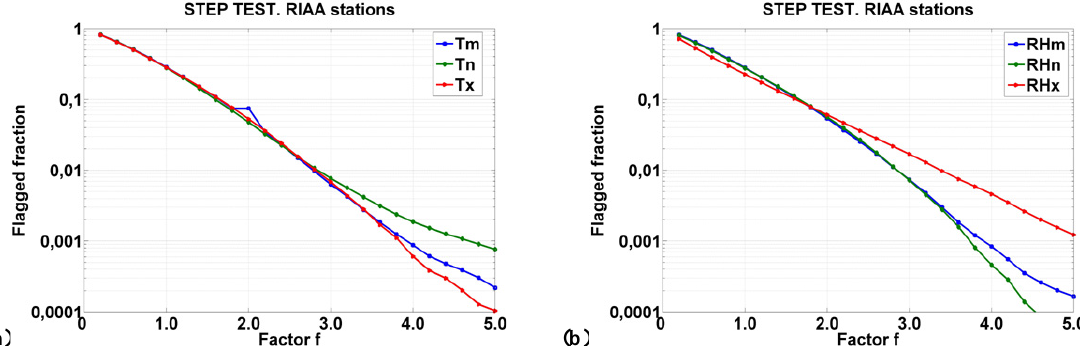
Figure 3. (a) Step Test – Maximum (Tx), minimum (Tn) and mean temperature (Tm). (b) Step Test – Maximum (RHx), minimum (RHn) and mean relative humidity